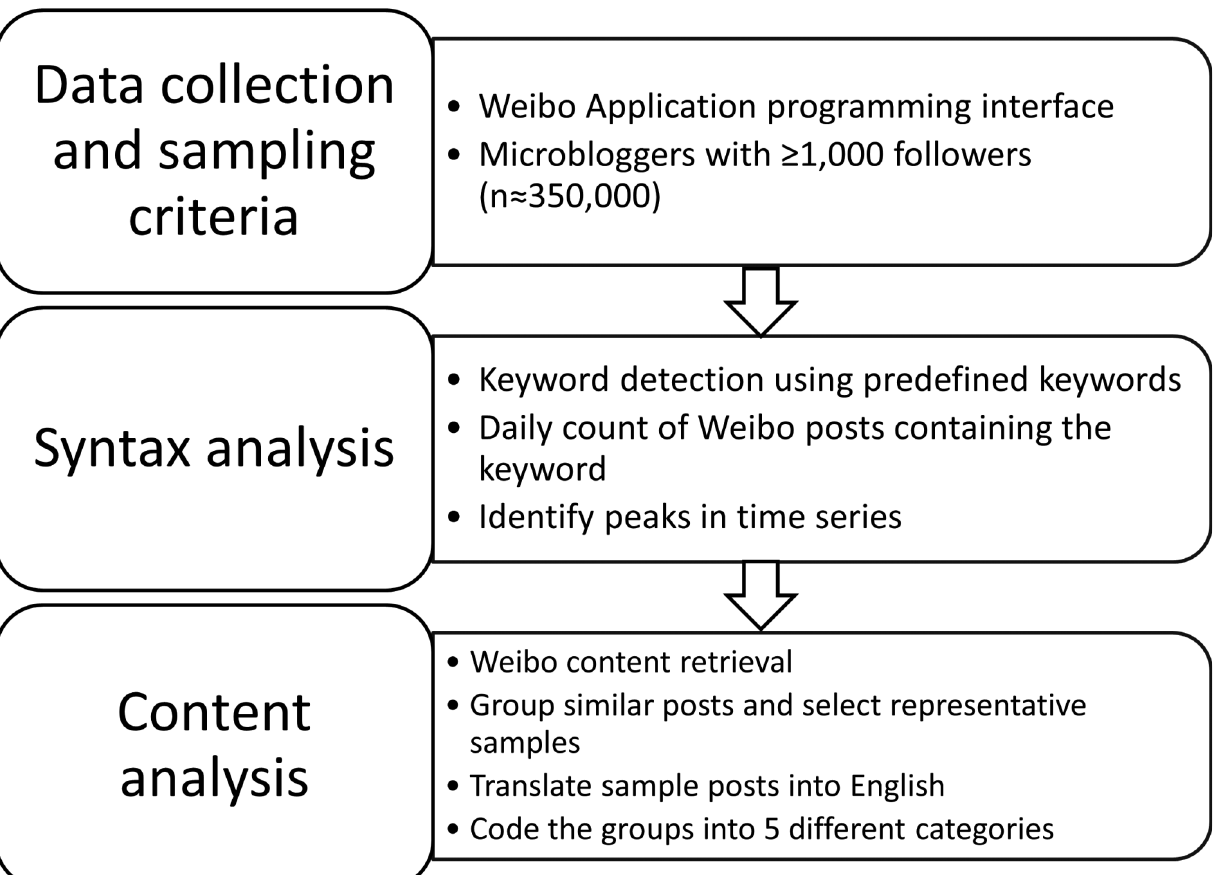
Fig 1. Flowchart of data collection, sampling criteria, syntax analysis and content